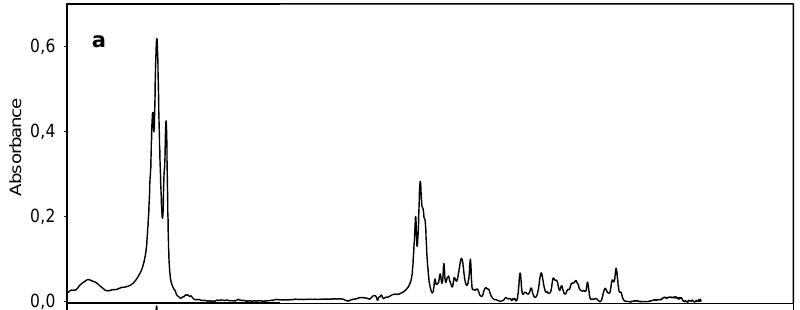
Figure 3. Spectra of N,N -dioctylazepanium bromide ( 1 ); (a) FTIR, (b) Raman and (c) calculated